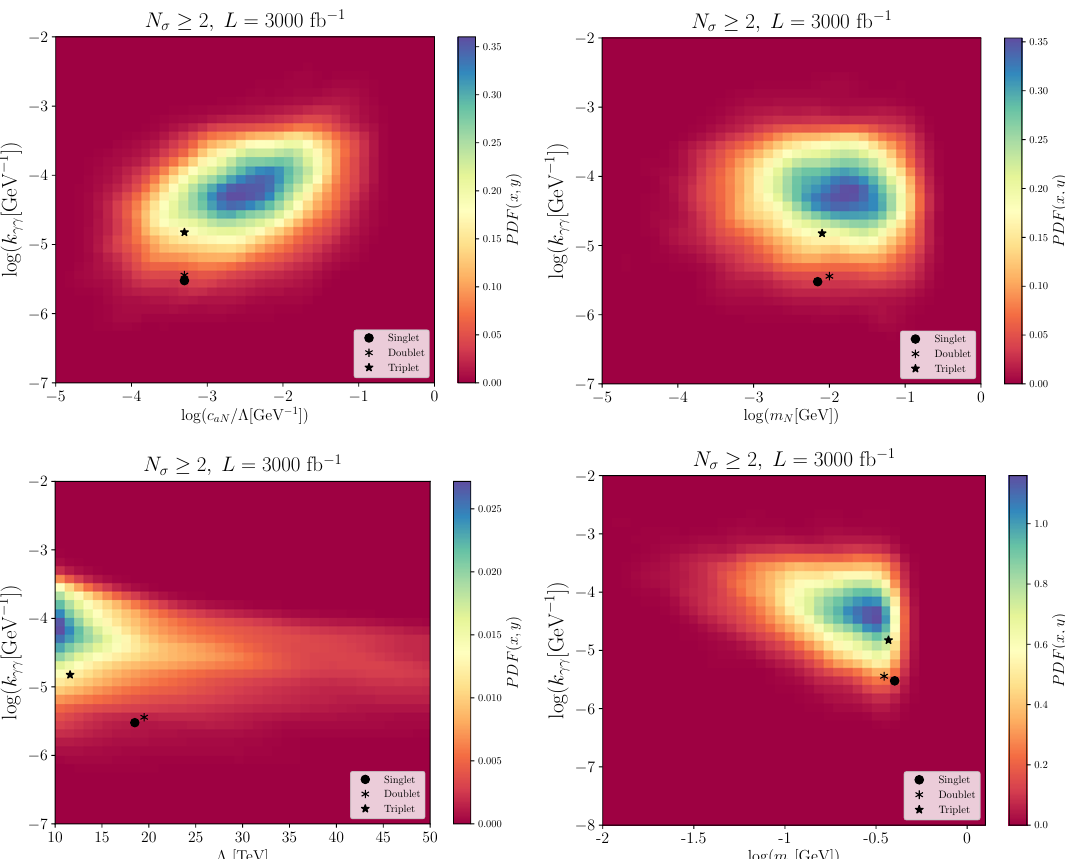
Figure 10 . Correlation between k (cid:13)(cid:13) and c aN , m N , (cid:3) and m a are shown at the upper left, upper right, lower left and lower right panel, respectively. For all plots, we impose N (cid:27) > 2 at the HL-LHC. The dot, asterisk and star represent examples of a singlet, doublet and triplet representation of the UV complete model presented in section 5,